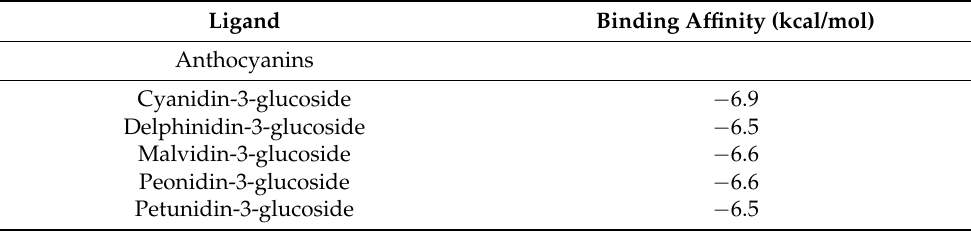
Figure 2. Interaction among the BTB domain of Keap1 protein and different anthocyanins. Table 2. Molecular docking results of the anthocyanins evaluated and BTB